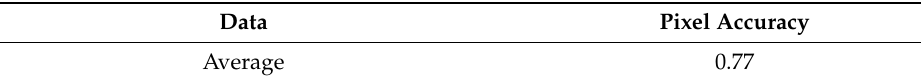
Table 9. Pixel accuracy of CMP test data.